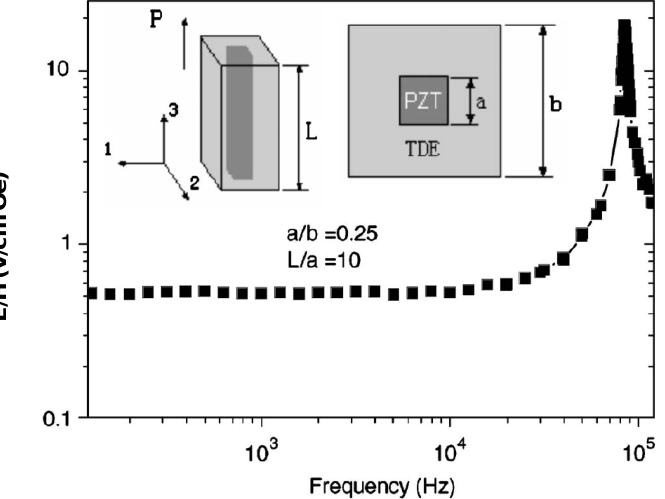
Figure 25. Frequency dependence of the ME coefficients for the small ME composite rod with a/b = 0.25 and L/a = 1